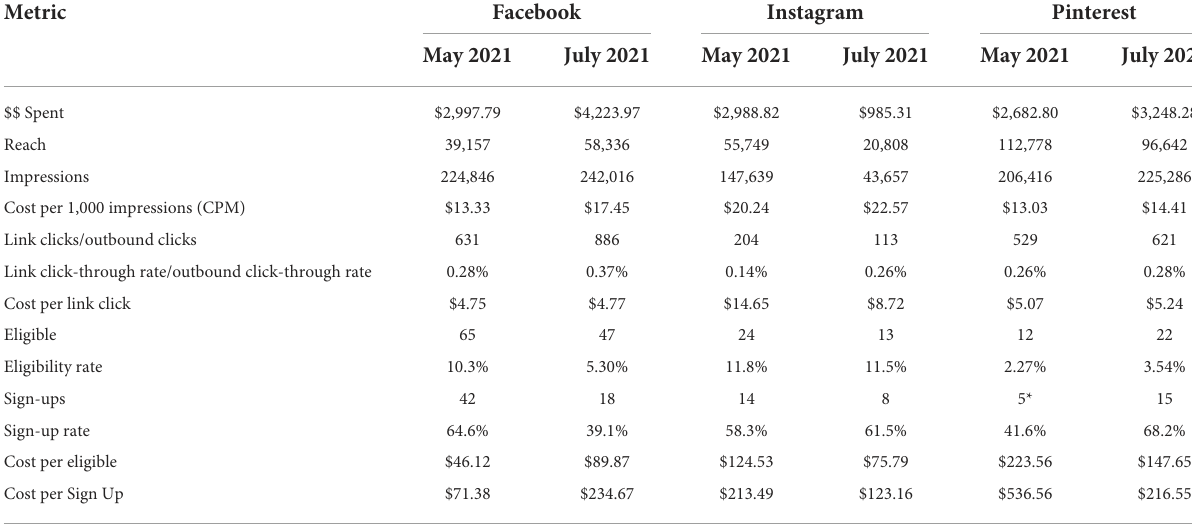
TABLE 1 Cost, reach, and effectiveness of ads on Facebook, Instagram, and Pinterest.